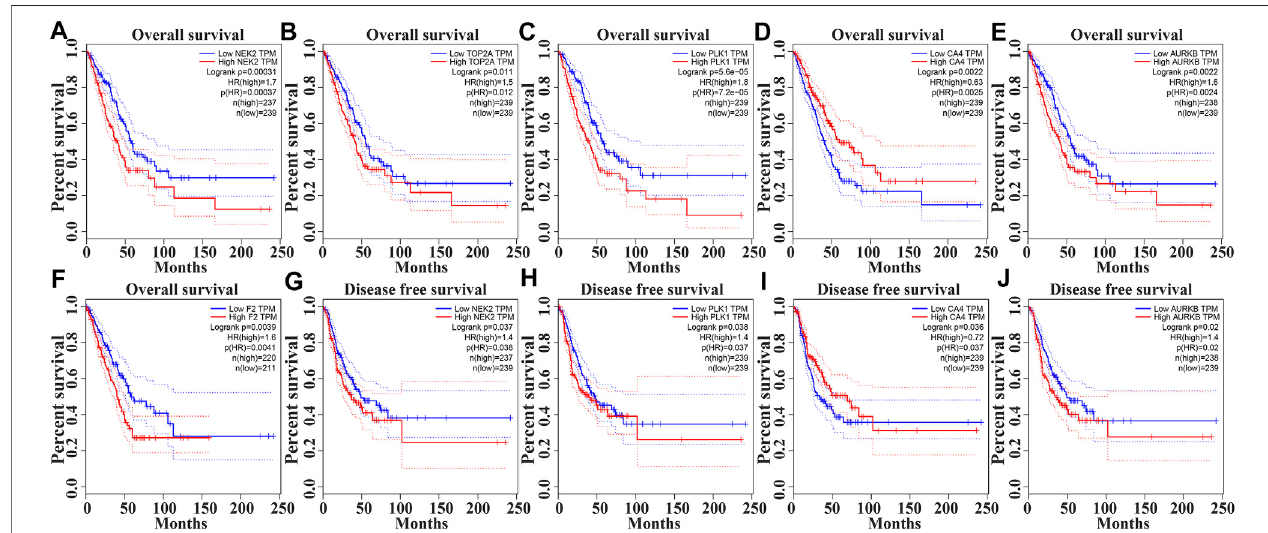
FIGURE 6 | The risk model factors were correlated with the prognosis of LUAD patients in the GEPIA database. Note: LUAD, lung adenocarcinoma; GEPIA, gene expression pro fi ling interactive analysis.